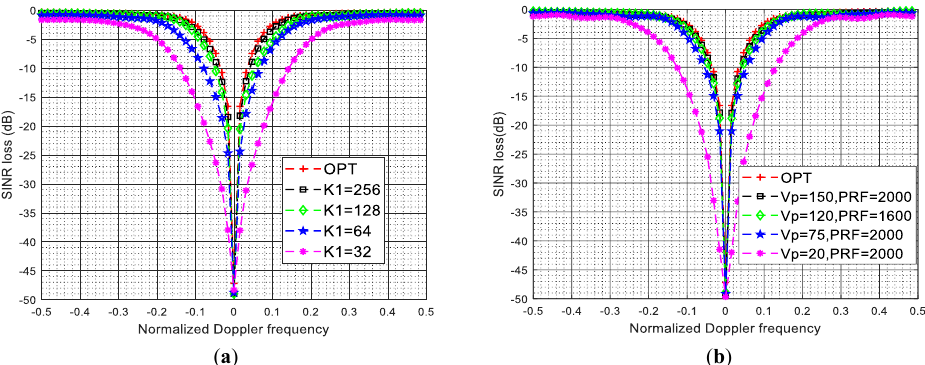
Figure 15. SINR loss curves of the MESV-MSBL method under different system parameters. ( a ) SINR loss curves of the MESV-MSBL method under different pulse numbers in a CPI in the first stage of the proposed two-stage SR-STAP method; ( b ) SINR loss curves of the MESV-MSBL method under different platform velocities and pulse repetition